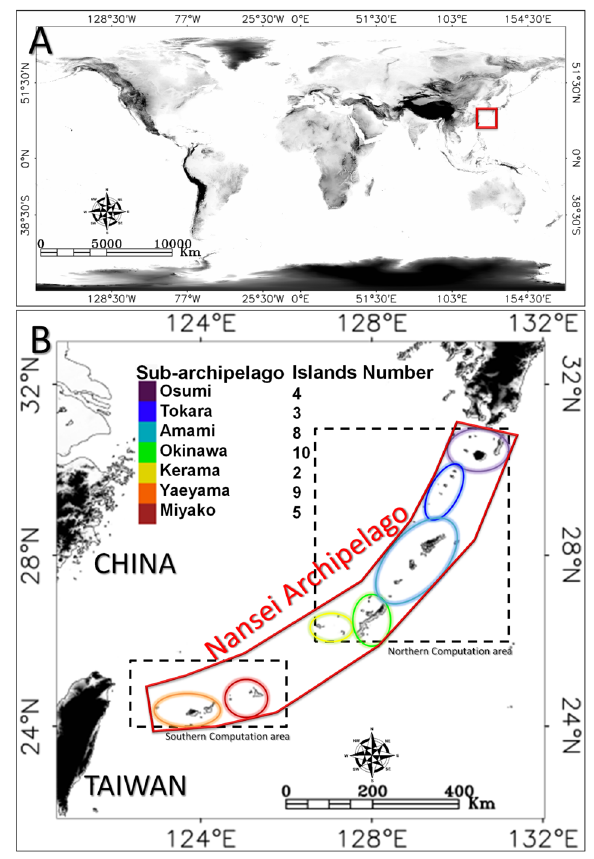
Figure 1. Location maps of the Nansei archipelago in ( A ) Southeast Asia, between ( B ) Taiwan and southern Kyushu. At 1200 km, the archipelago is composed of seven sub-archipelagoes and is examined as two study areas: northern and southern areas comprising five and two sub-archipelagoes,